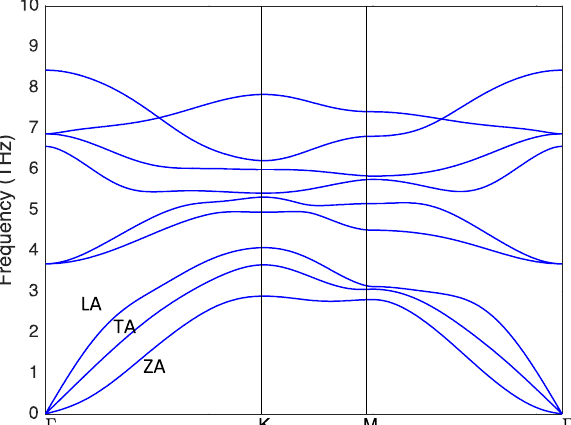
Figure 2. Phonon dispersion relation of the monolayer NbSe 2 . The three acoustic phonon modes are labeled.